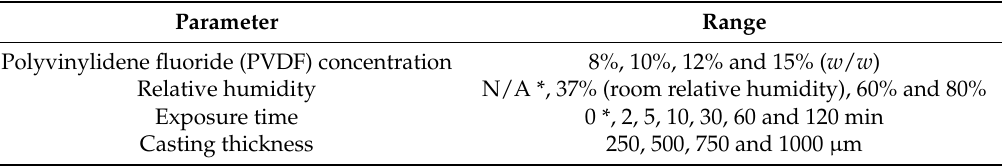
Table 1. Summary of membrane preparation